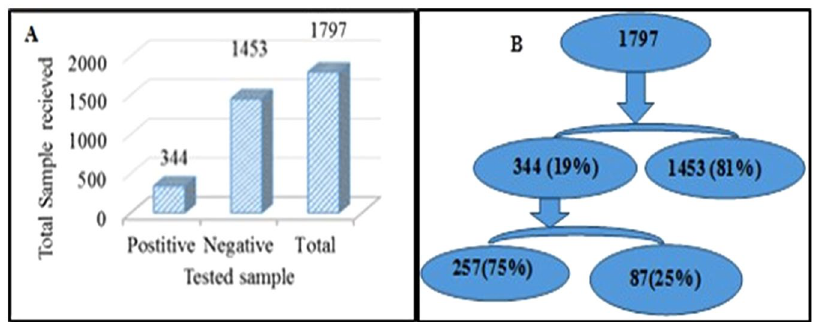
Figure: 1. ( A ) Distribution of infected and uninfected patients based on PCR diagnostic assay using total genomic DNA isolated from clinical samples. ( B ) Diagrammatic representation of distribution of infected and uninfected patients for single or mixed infection. The distribution of infection with T. vaginalis , N. gonorrhoeae and C. trachomatis out of the total symptomatic patients enrolled in the study is